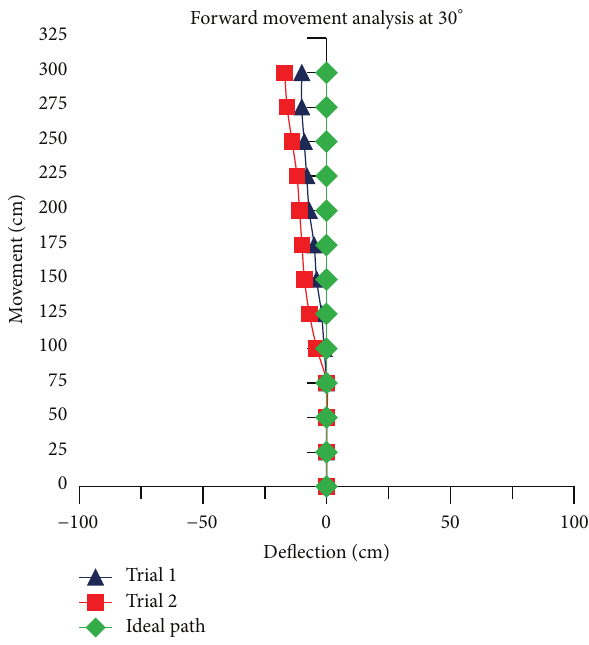
Figure 11: Forward movement versus deflections at 𝜃 = 30 ∘ .